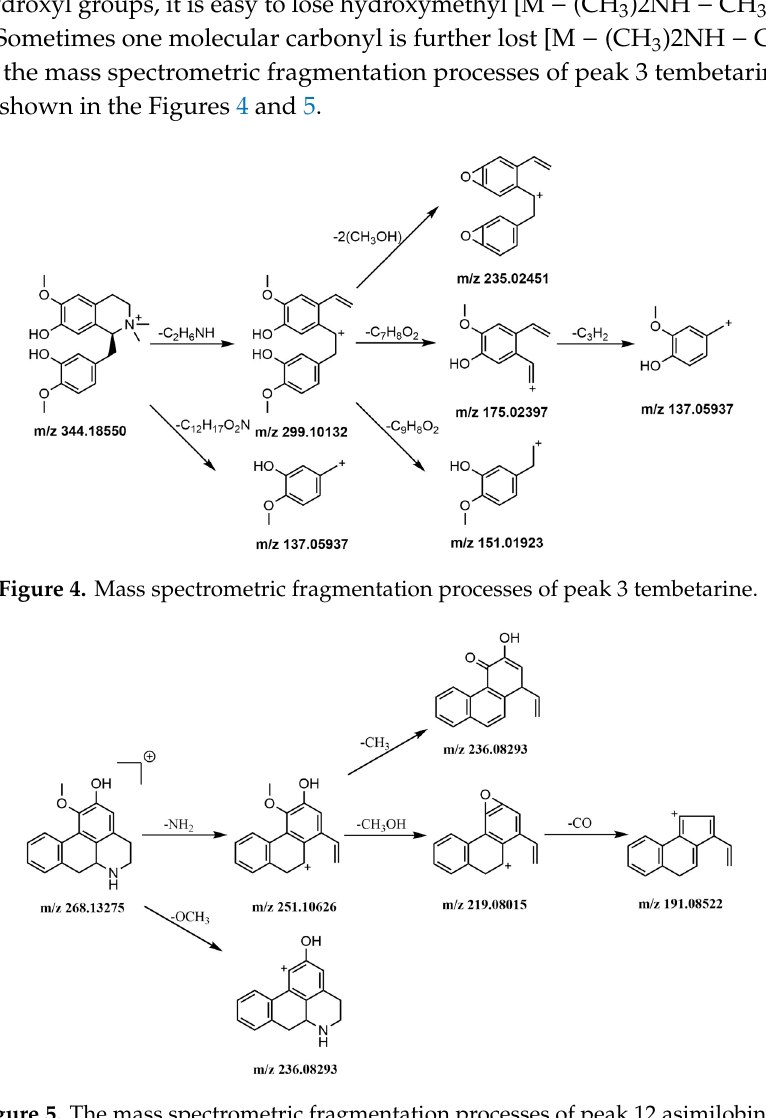
Figure 5. The mass spectrometric fragmentation processes of peak 12 asimilobine.